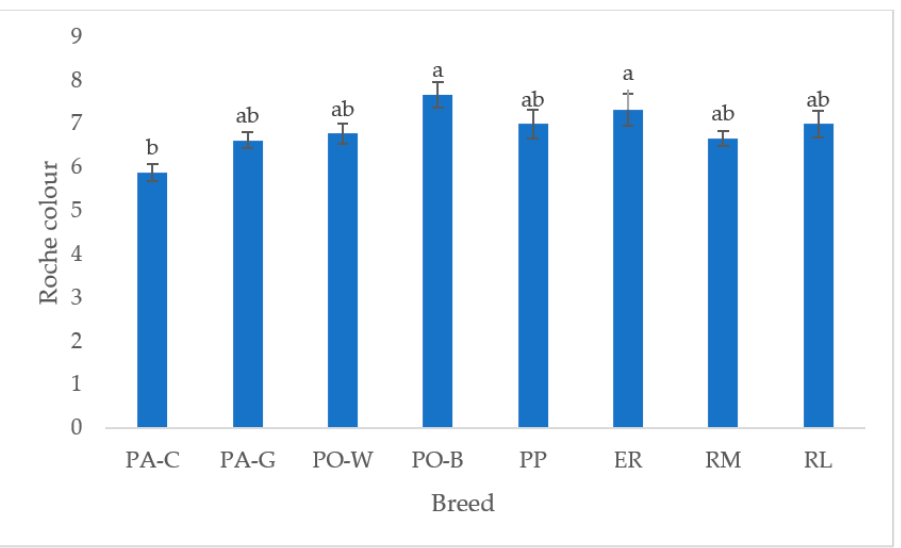
Figure 6. Least squares means (with SE) of yolk Roche colour (PA ‐ C: Padovana Camosciata; PA ‐ G: Padovana Dorata; PO ‐ W: Polverara Bianca; PO ‐ B: Polverara Nera; PP: Pepoi; ER: Ermellinata di Rovigo; RM: Robusta Maculata; RL: Robusta Lionata). Different letters indicate statistically different means (a,b: p < 0.05). Observations ( n ) = PA ‐ C (9), PA ‐ G (8), PO ‐ W (9), PO ‐ B (9), PP (9), ER (9), RM (9), RL (7).